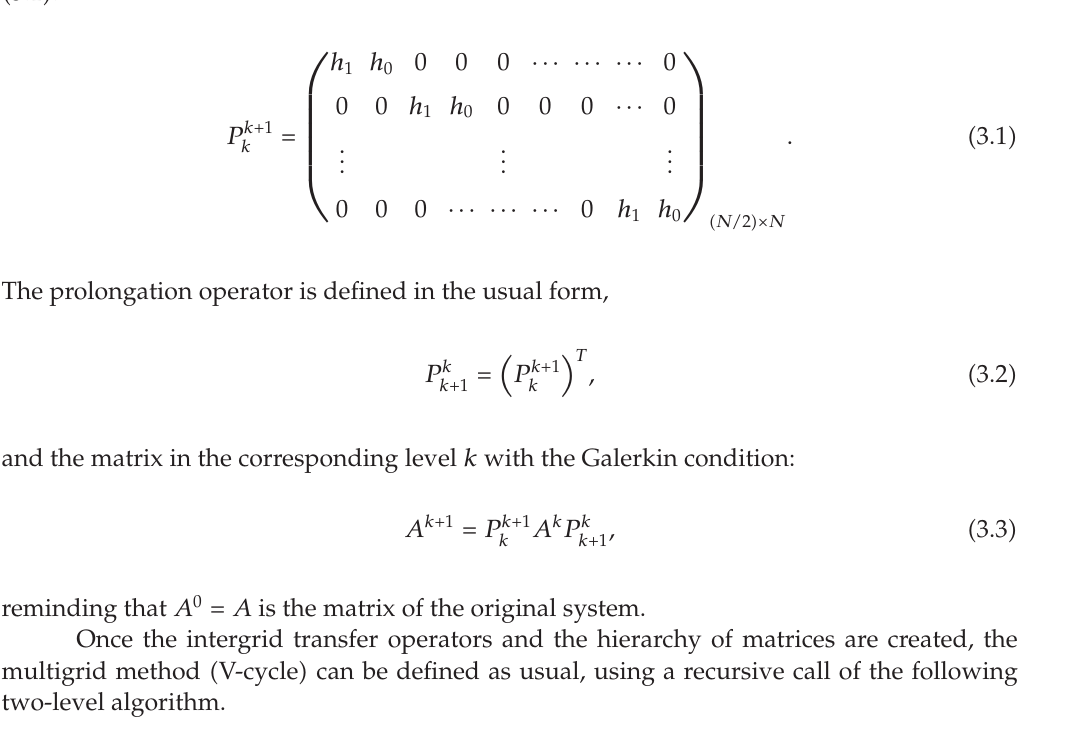
defined in (cid:2) 2.2 (cid:3) in the rows and columns of the matrix, the operation is matricially defined as